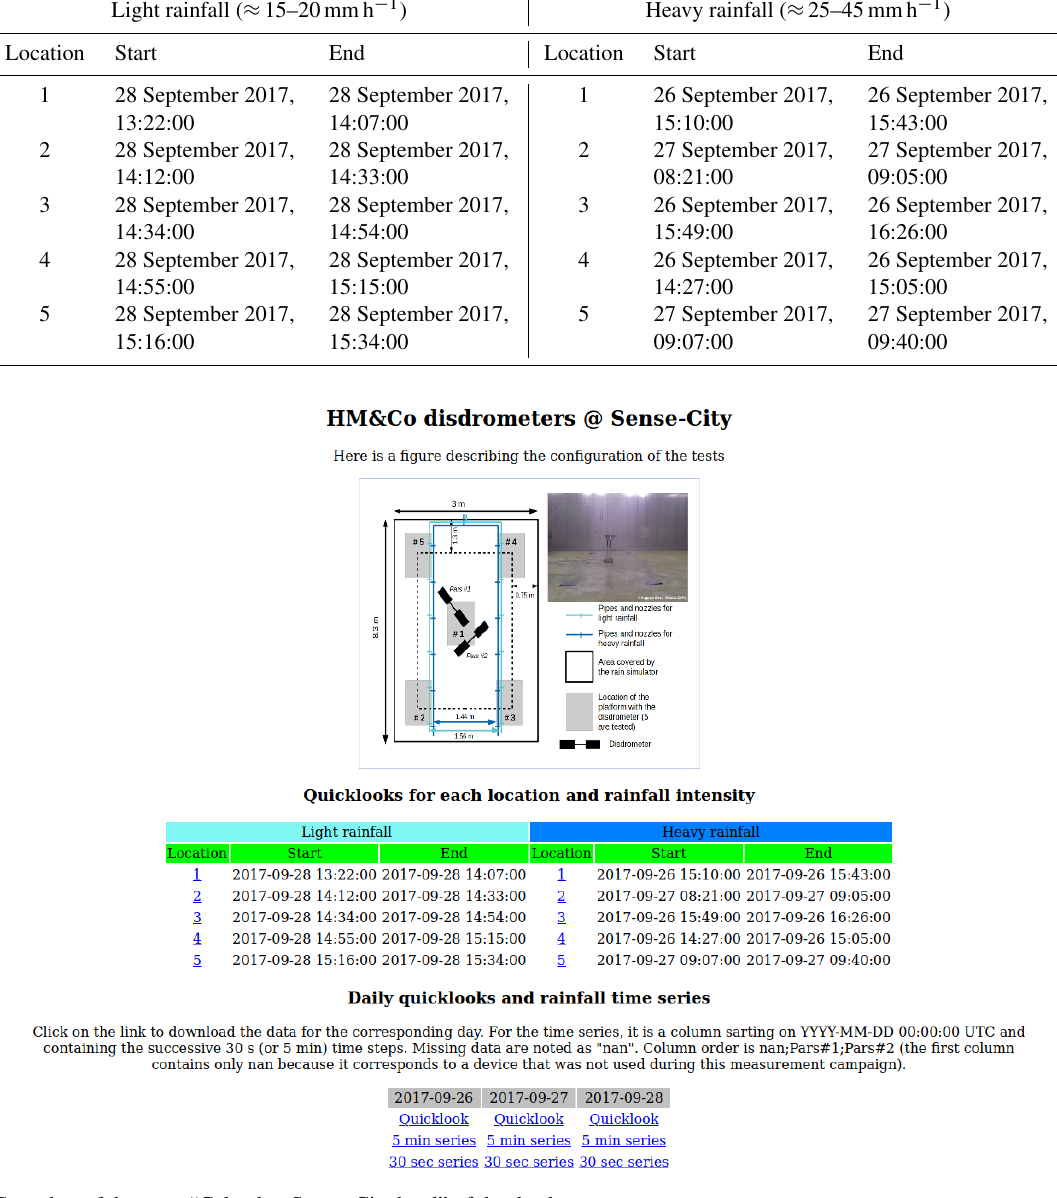
Figure 3. Snapshot of the page “Calendar_Sense_City.html” of the